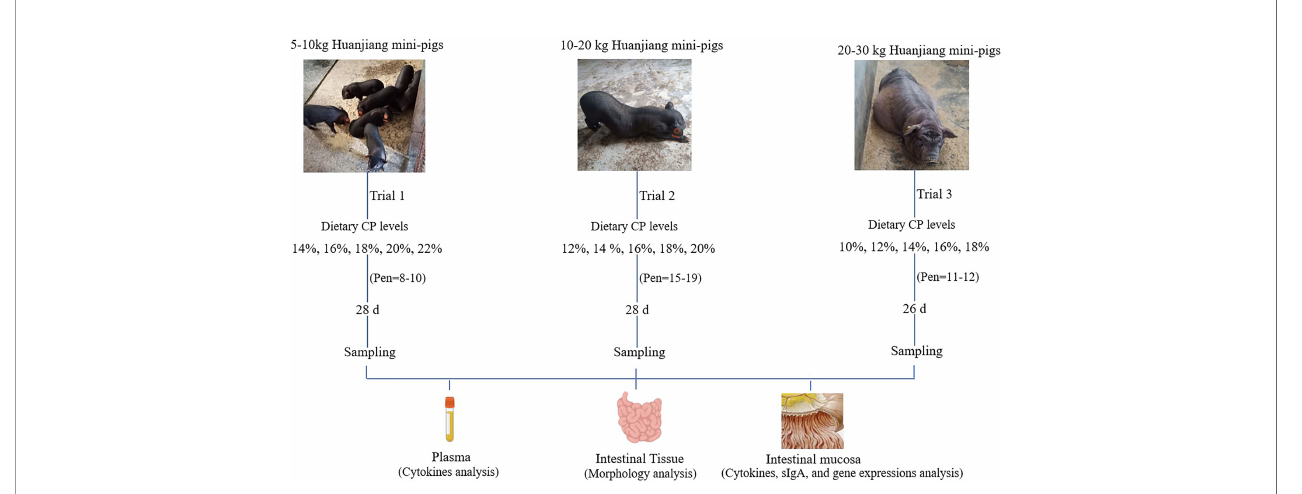
FIGURE 1 | Schematic presentation of the experimental design of dietary crude protein (CP) levels on diarrhea incidence, immunity, and intestinal barrier function of Huanjiang mini-pigs during different growth